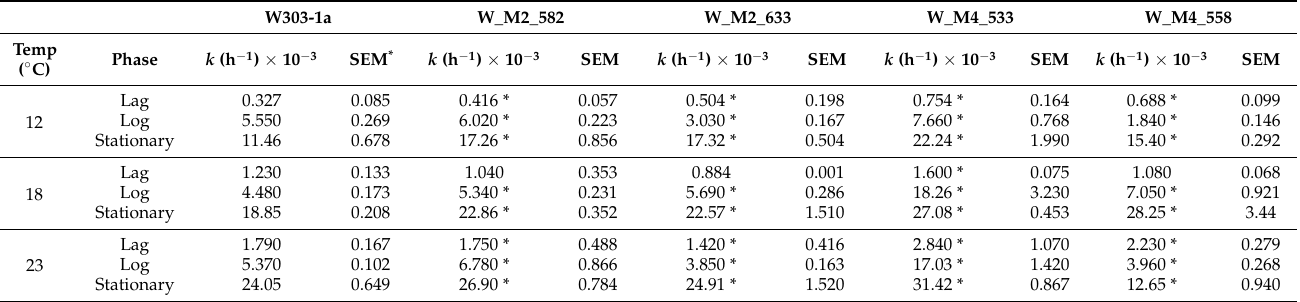
Table 3. Calculated hexose consumption reaction rate constants values ( k ) for each strain during fer- mentation phases at 12, 18 and 23 ◦ C. The * indicates the observed statistically significant differences between genetically modified strains and wild type ( p <